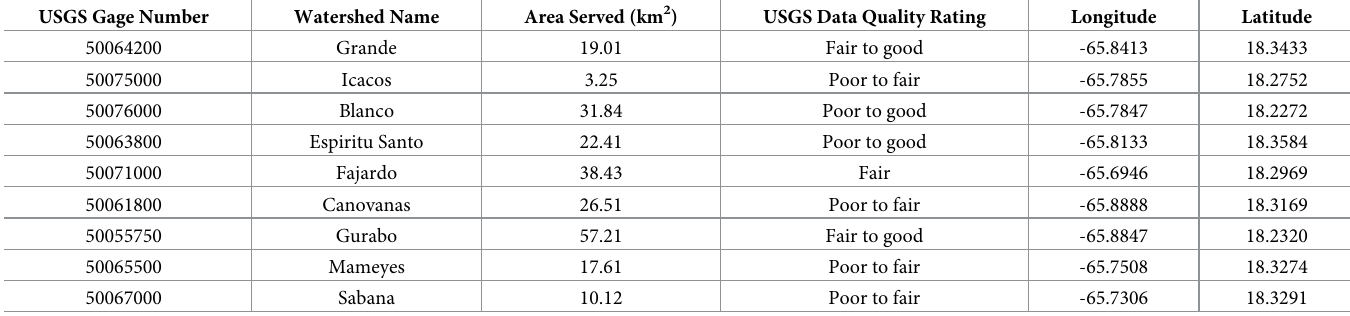
Table 1. U.S. Geological Survey streamflow gages used in this study. Data quality for gaging stations varied between gages and between years over the period of analysis. According to the USGS, a gage is excellent if 95% of discharge readings are within 5% of true values, good if 95% of discharge readings are within 10% of true values, fair if 95% of discharge readings are within 15% of true values, and poor if accuracy is less than fair